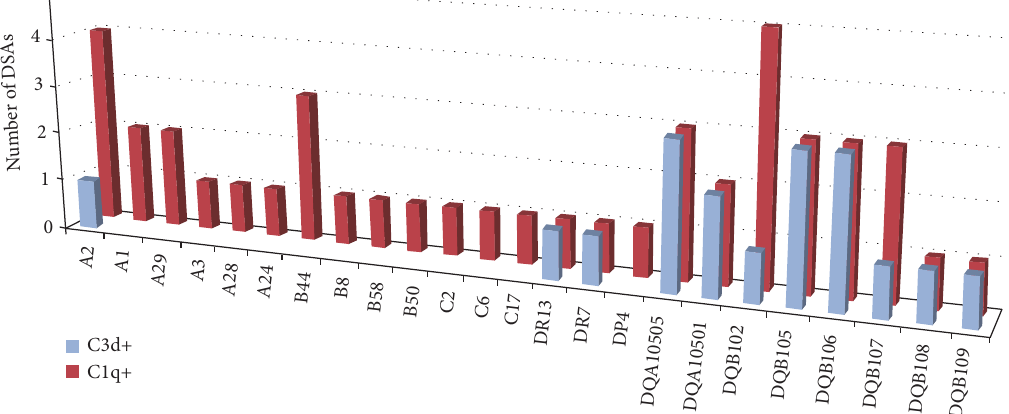
Figure 1: HLA antigens recognized by C3d and/or C1q positive DSAs in the 39 dn DSA-positive patients. A total of 78 dn DSAs were identified in the 39 kidney recipients. Of those, 44 bound C1q and 18 displayed binding ability for C3d.